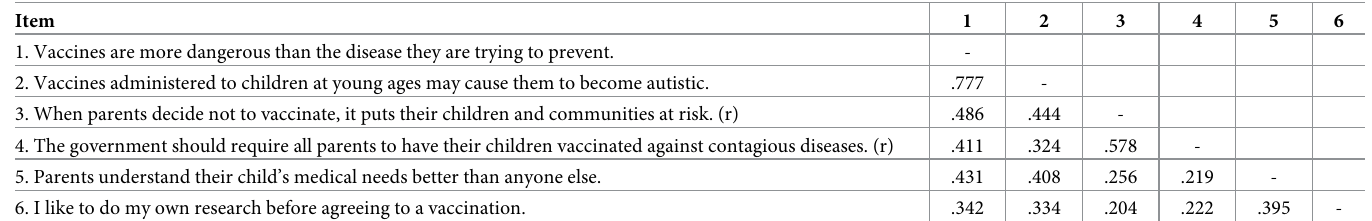
Table 3. Anti-vax scale item correlations.